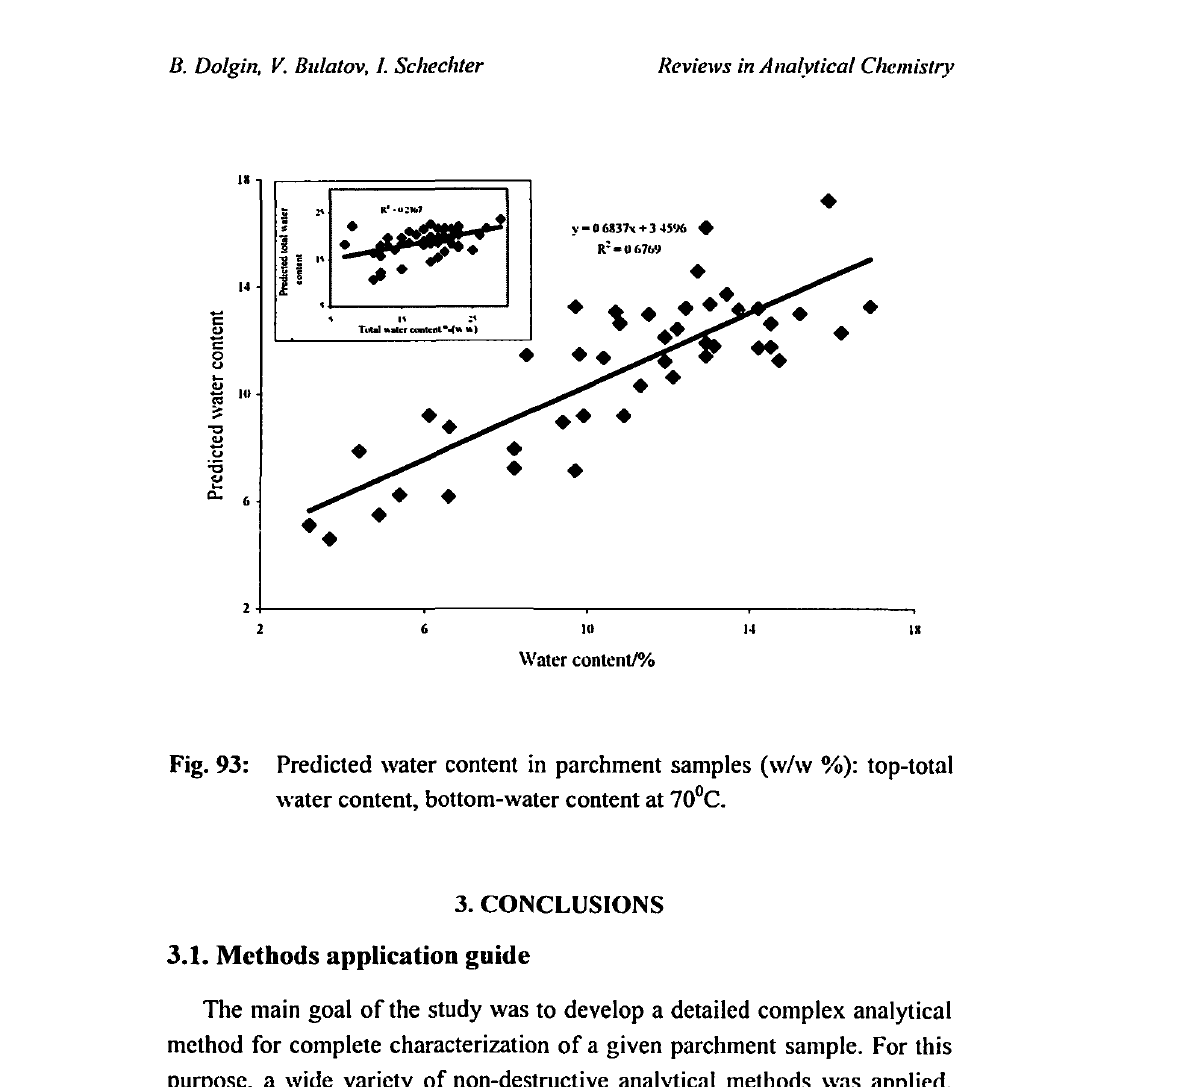
Fig. 93: Predicted water content in parchment samples (w/w %): top-total water content, bottom-water content at